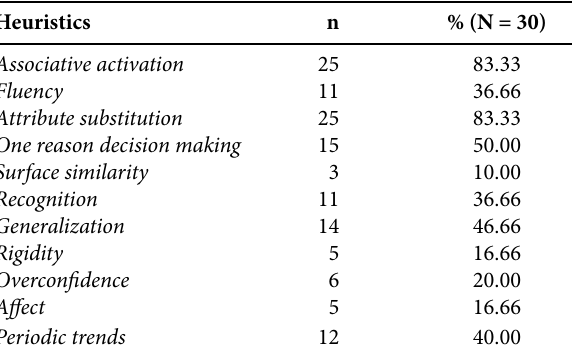
Table 5. Number and percentages of participants using relevant heuristic at least once (relative basicity strengths of compounds KOH, Mg(OH) 2 and Ca(OH) 2